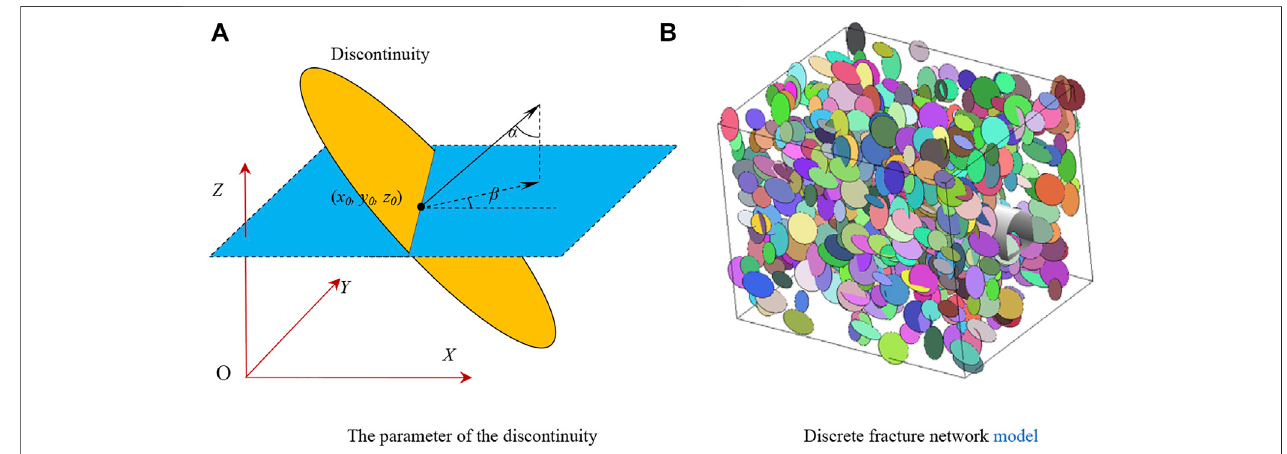
FIGURE 2 | Disk model of discontinuities. (A) The parameter of the discontinuity. (B) Discrete fracture network model.